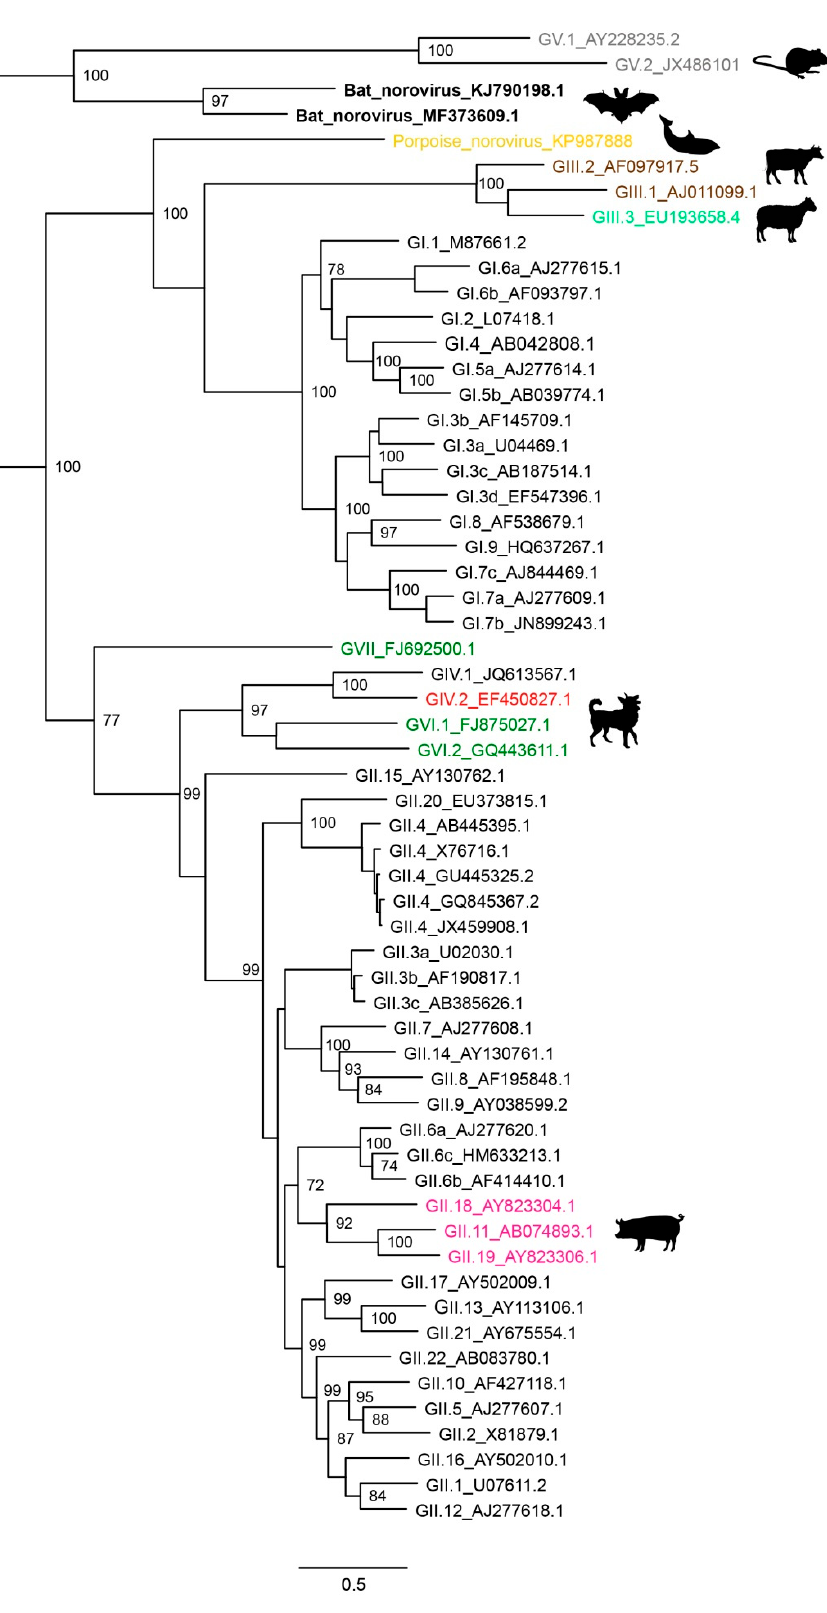
Figure 2. Maximum-likelihood tree of open reading frame 2 (ORF2). The tree was inferred by PhyML 3.0 software (http://www.atgc-montpellier.fr/phyml/) by using the general time reversible nucleotide substitution model. Bootstrap values >70 are shown. Scale bars indicate nucleotide substitutions per site. Animal noroviruses are colored with same color code as in Figure 1A.